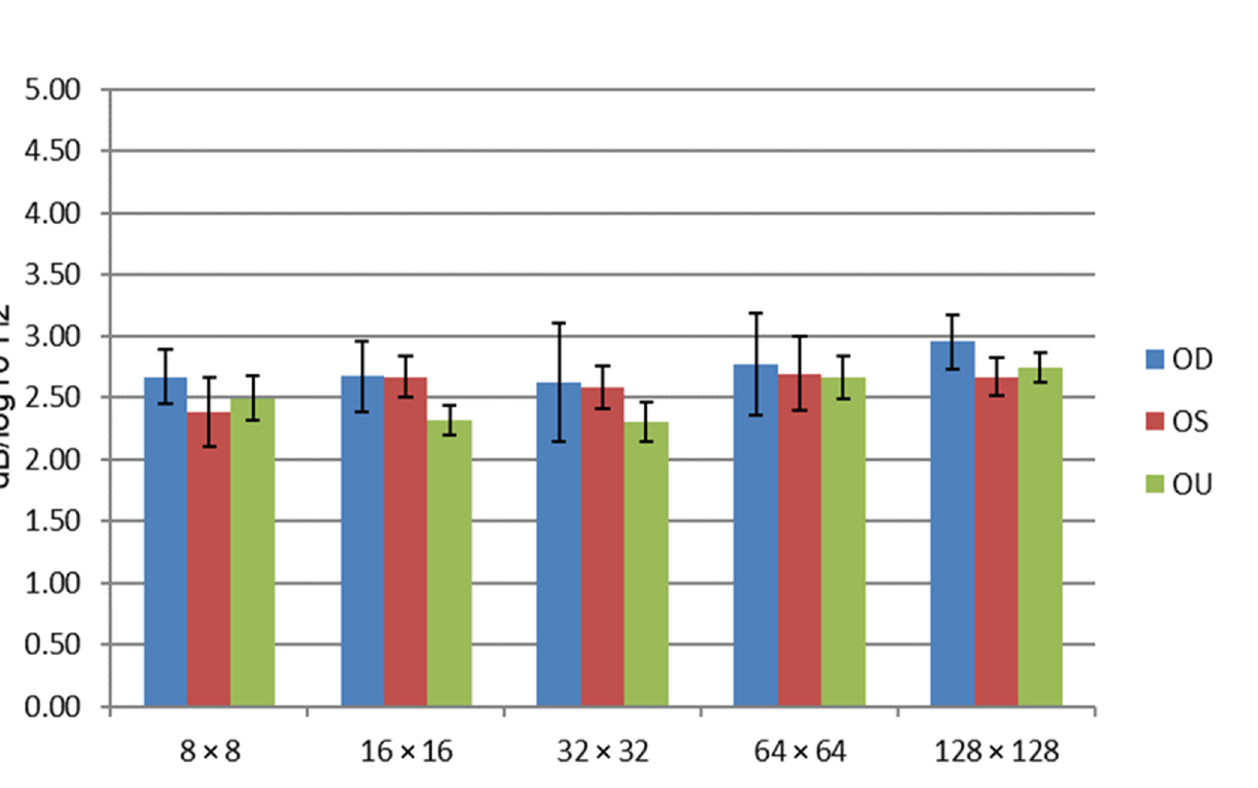
Figure 3. Display of mean power spectral density (PSD) values for OD, OS and OU for mTBI ( a ) and controls ( b ). Spatial frequencies are on the x-axis. Significance thresholds designated at: ** = p < 0.01, *** = p < 0.003.